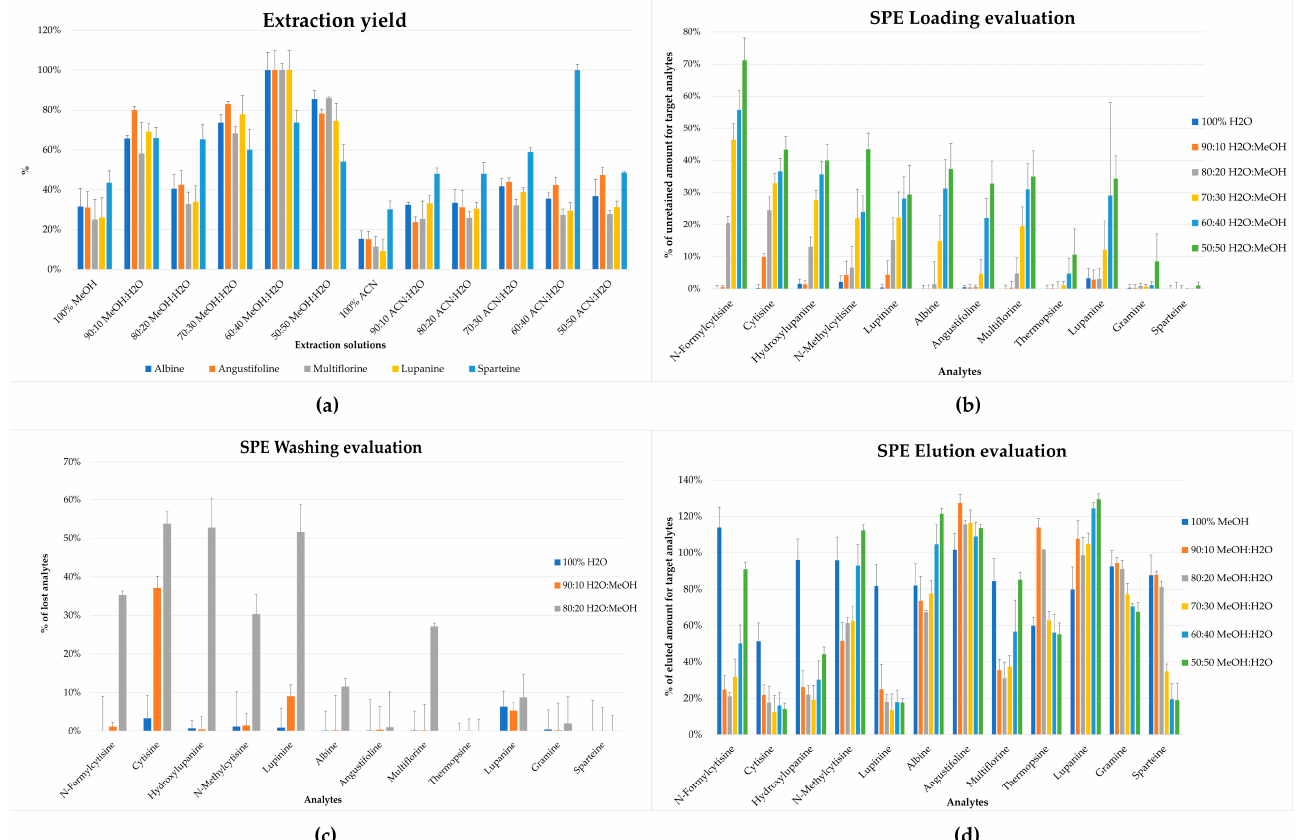
Figure 2. Evaluation of extraction and clean-up. ( a ) Extraction yield with different ratios of MeOH:H 2 O and ACN:H 2 O ( v : v ) for the most representative alkaloids in L. albus L.; all data were normalized (%) to the highest obtained value. ( b ) Loading tests; amount of retained compounds is reported. ( c ) Washing tests; amount of lost compounds is reported. ( d ) Elution tests; amount of eluted compounds is reported.